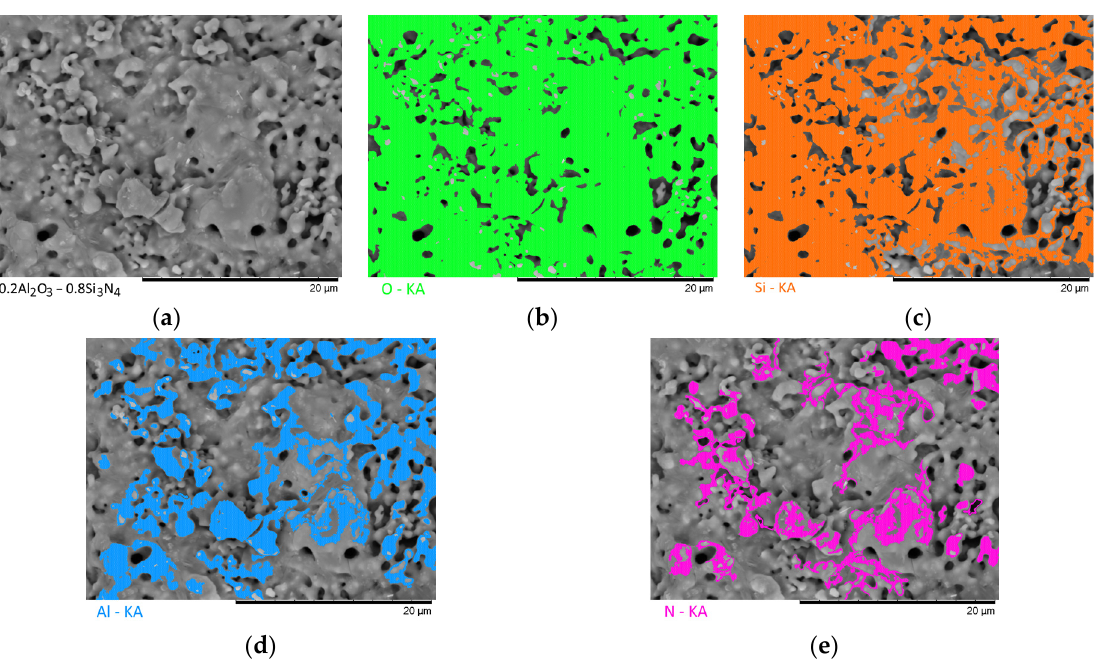
Figure 5. Results of morphological studies and mapping of a ceramic sample with an Al 2 O 3 content of 0.3 mol: ( a ) SEM image; ( b ) oxygen distribution results; ( c ) silicon distribution results; ( d ) alu- minum distribution results; ( e ) nitrogen distribution results